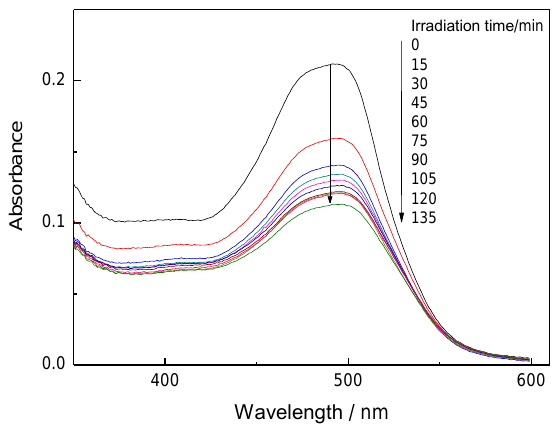
Figure 4. Absorbance spectra of OG-AA aqueous solution in contact with the 3C 60 / MCM-41 photocatalyst at various irradiation times after equilibration in the dark.